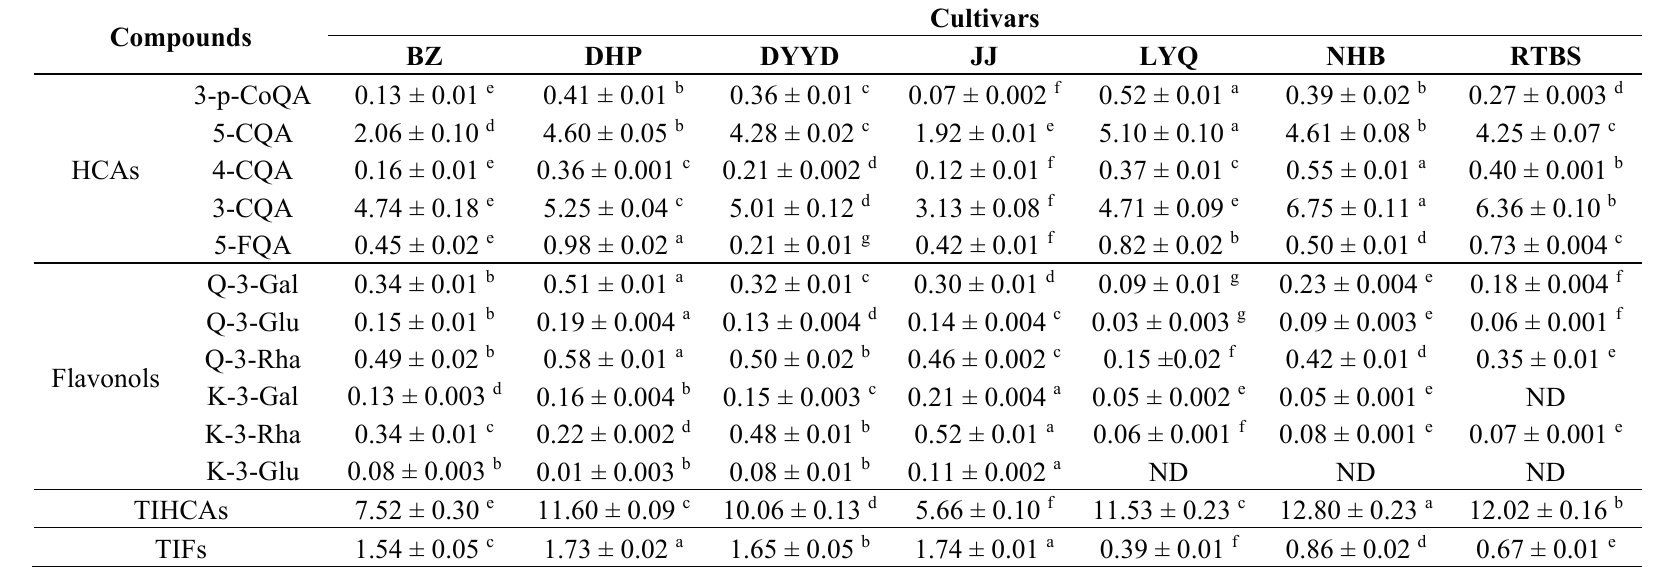
Table 3. Contents of individual phenolic compounds in the peel of seven loquat cultivars (mg/g DW).